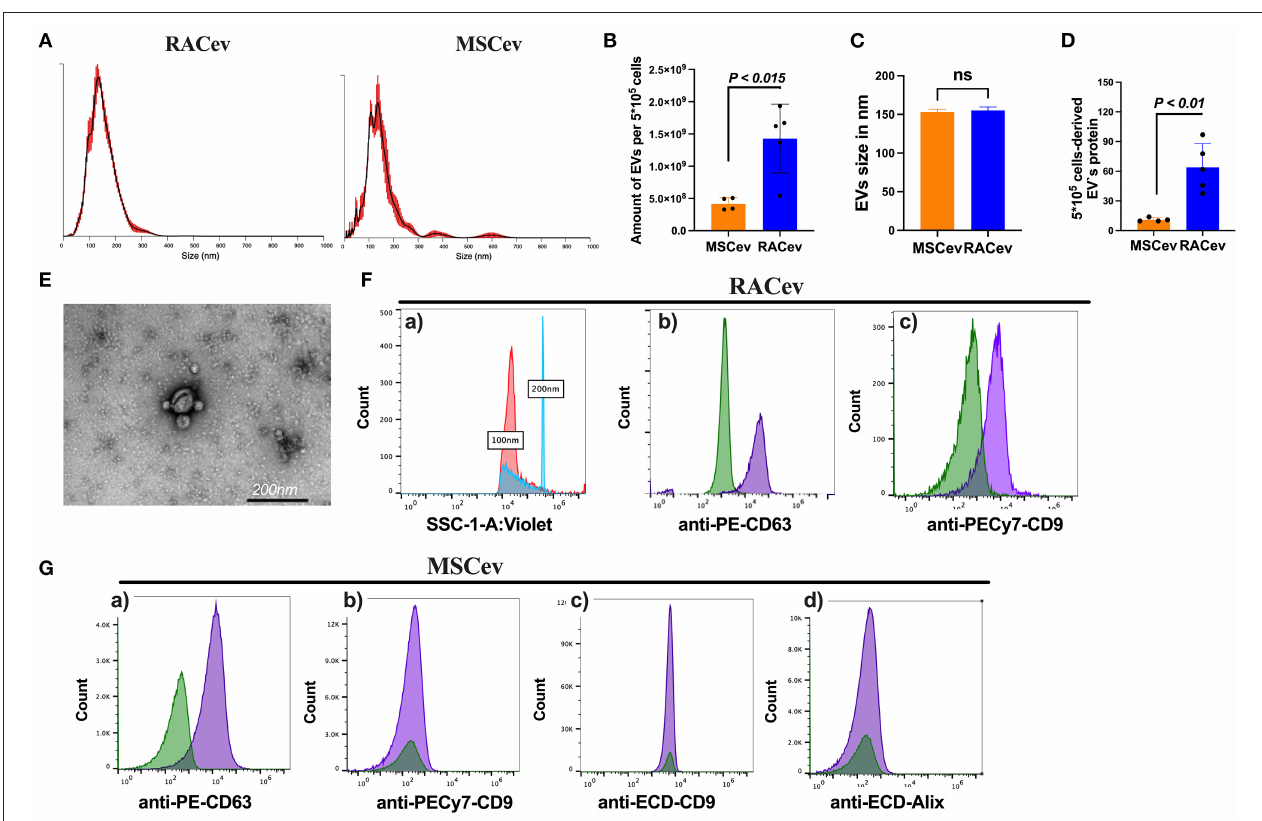
FIGURE 1 | Characterization of extracellular vesicles. (A–C) Nano tracking particle analysis of EV characteristics such as size and quantity. (D) Representative transmission-electron microscopy figures showing the lipid bilayer structure of EVs. Distinct EV biomarkers expression profiles such as CD9, CD63, and Alix of (E,F) RACev and (G) MSCev. Statistical significance was determined using Mann-Whitney U test. The results are presented as mean ± SEM ( n = 4–7 per group).